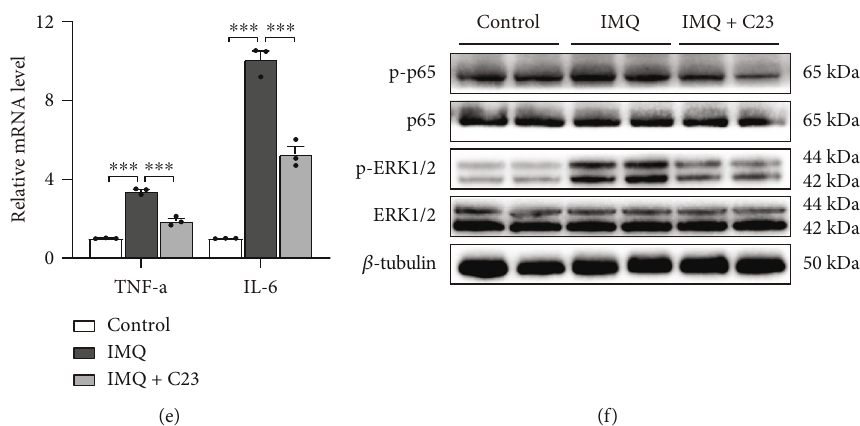
Figure 6: E ff ects of C23 on IMQ-induced psoriatic mice. (a) Representative images of each group. (b) Single (erythema, scaling, and thickness) and cumulative scores of skin lesions in each group ( n = 5 mice/group). (c) Representative H&E staining of back skin sections of each group. Scale bar = 100 μ m. (d) Microscopic quanti fi cation of epidermal hyperplasia in the back skin of mice in each group ( n = 5 mice/group). (e) qRT-PCR analysis of TNF- α and IL-6 mRNA levels in the back skin of mice in each group ( n = 3 ). (f) Western blot analysis of the phosphorylation of NF- κ B p65 and ERK1/2 in skin tissues from the three groups. Data are expressed as the mean ± SEM . ∗ P < 0 : 05 , ∗∗ P < 0 : 01 , and ∗∗∗ P < 0 : 001